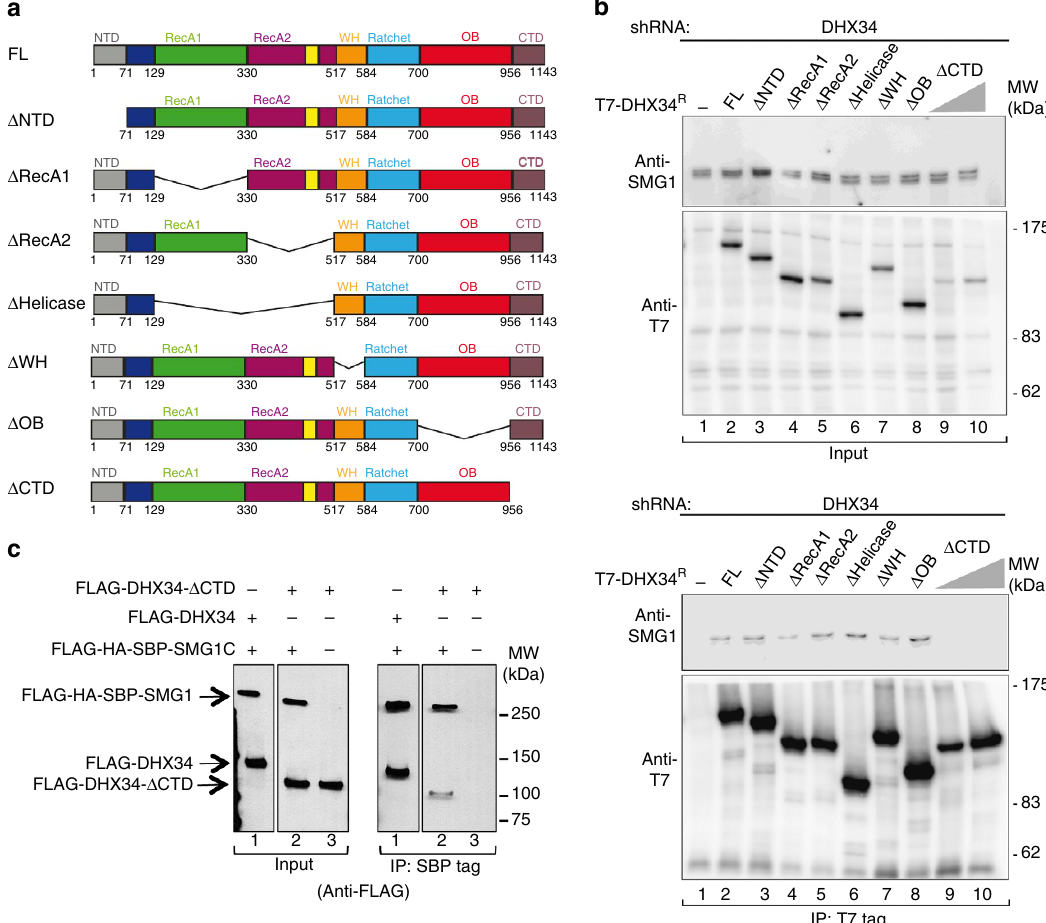
Figure 4 | The CTD domain in DHX34 is the only domain required to bind SMG1 in vivo and in vitro . ( a ) Cartoon depicting the domain structure of DHX34 full length (FL) and mutants carrying deletions of individual domains. ( b ) HEK293Tcells depleted of DHX34 with a specific shRNA were transfected with an shRNA-resistant version of full-length T7–DHX34 and DHX34 deletion mutants. Anti-T7 immunoprecipitates (20%, lower panel) were probed for the presence of SMG1. Inputs (0.5%) are shown on the upper panel. ( c ) Pull-down experiment testing the interaction of purified FLAG-DHX34 or mutant ( D CTD) DHX34 to FLAG-SBP-HA-SMG1C. Proteins bound to Streptavidin Sepharose beads were eluted using biotin and analysed by SDS–PAGE and western blotting against the FLAG-tag in SMG1 and